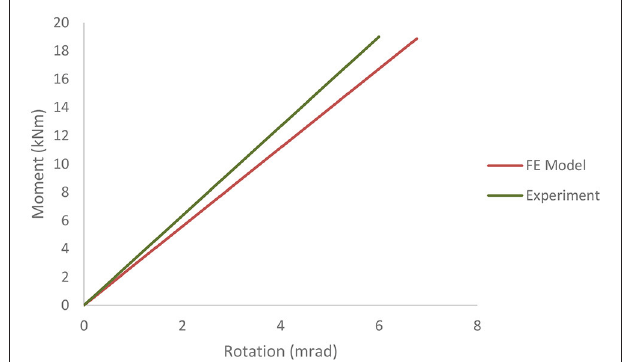
FIGURE 4 | Verification of numerical